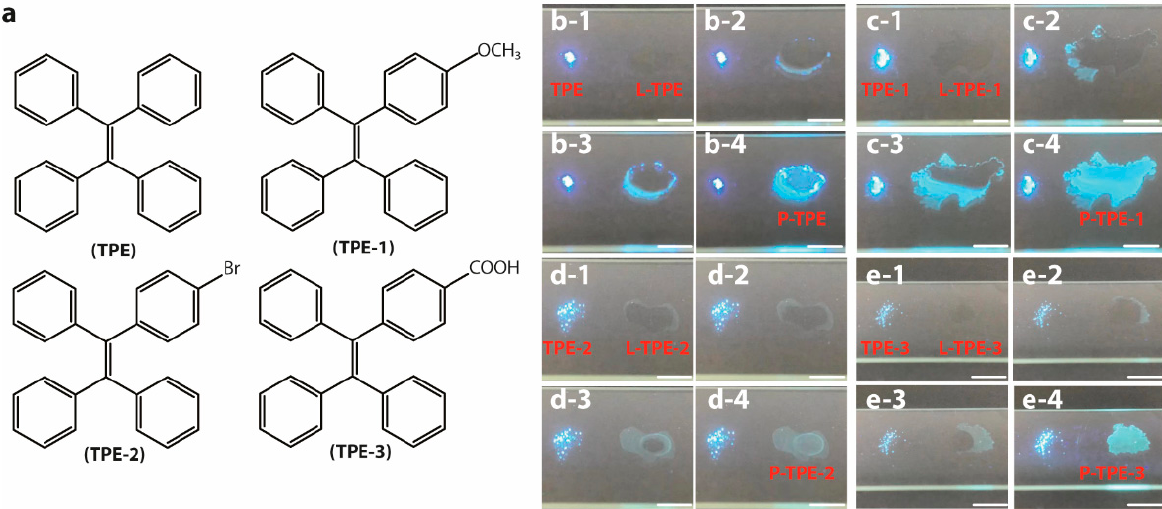
Figure 1. ( a ) Schematic molecular structures of TPE, TPE-1, TPE-2, and TPE-3. Direct conversion photos of ( b-1 – b-4 ) L-TPE (10 mg/mL), ( c-1 – c-4 ) L-TPE-1 (5 mg/mL), ( d-1 – d-4 ) L-TPE-2 (2 mg/mL), and ( e-1 – e-4 ) L-TPE-3 (5 mg/mL), transforming from the dissolved state to precipitated solid state (P-TPE- y ) all compared to their corresponding TPE- y under 365 nm UV irradiance.